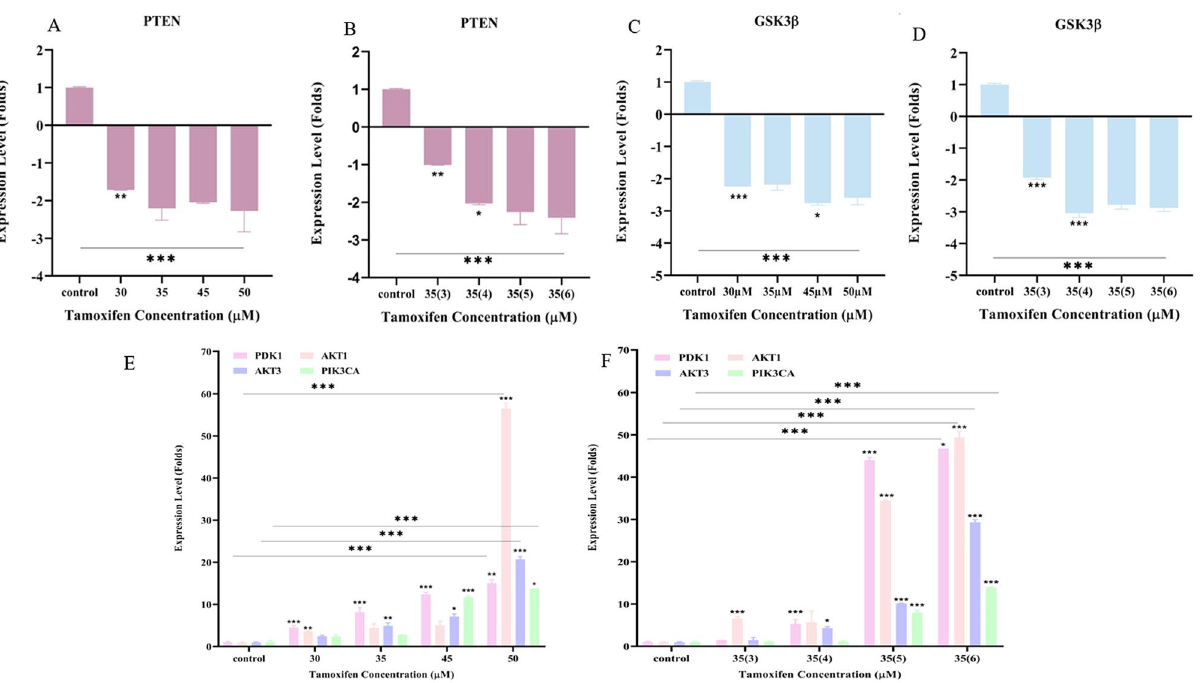
Figure 3. Levels of gene expression (Folds increase and decrease) during the development of TAM-R of PTEN ( A , B ), GSK3ß , ( C , D ) and PDK1, AKT1,AKT3, PIK3CA ( E , F ) using the first and second approaches respectively. Gene expression analysis was performed in triplicates in each run and repeated twice as independent experiments. Folds increase and decrease were presented ± SD. Comparisons were performed between each dose with the previous dose and the last dose with the control untreated sensitive MCF-7 cells via one-way and 2 way annova ANOVA. P* < 0.05, P** < 0.01, and P*** <